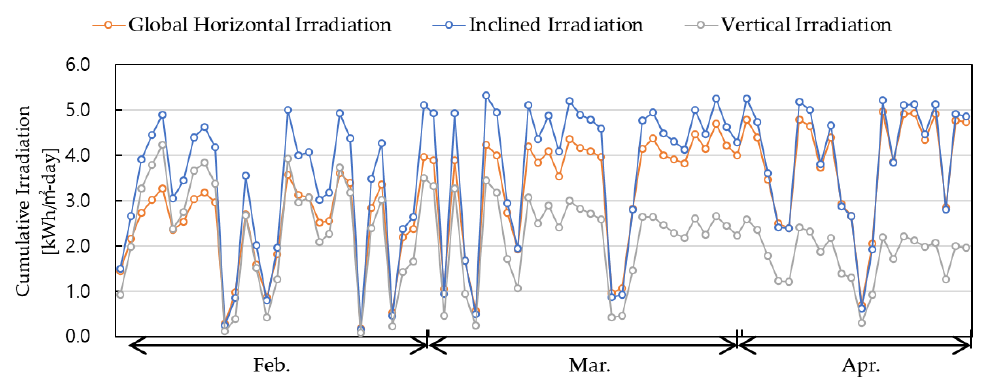
Figure 6. Cumulative irradiances of each plane for three months .